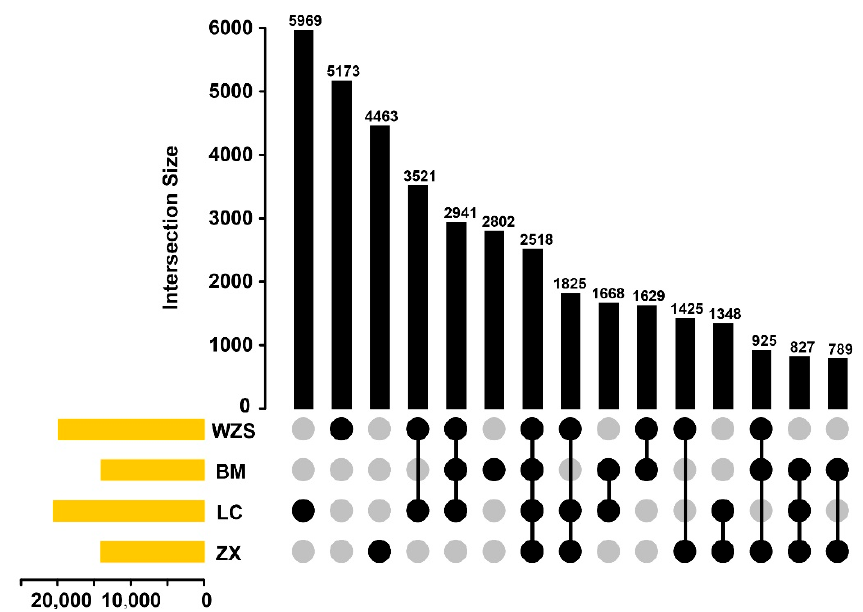
Figure 3. Overlapping analysis of SSRs among four pig breeds. The horizontal frames (in yellow) represent the total number of mapped SSRs with an SSLP more than 1 corresponding to the four pig breeds. The vertical frames (in black) show the SSR number corresponding to the bottom intersection groups.